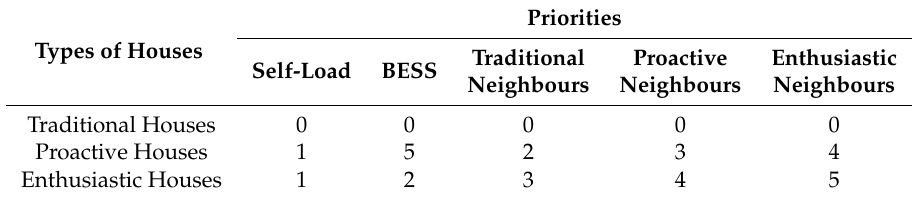
Table 1. Priorities for sharing power in a microgrid with different types of houses during the islanded mode.